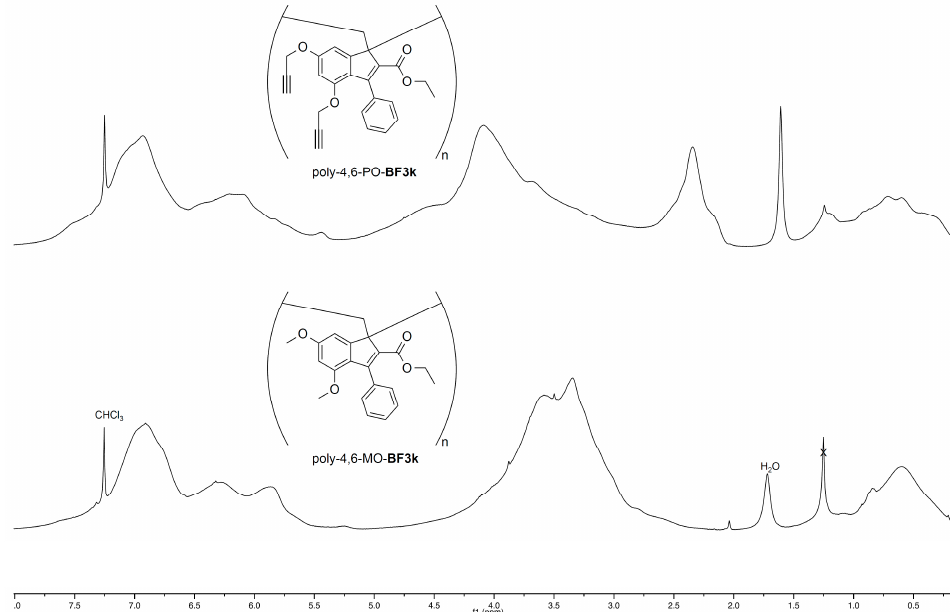
Figure 7. 1 H NMR spectrum (CDCl 3 ) of poly-4,6-PO- BF3k ( top trace ) compared with that of previously reported poly-4,6-MO- BF3k ( bottom trace ).